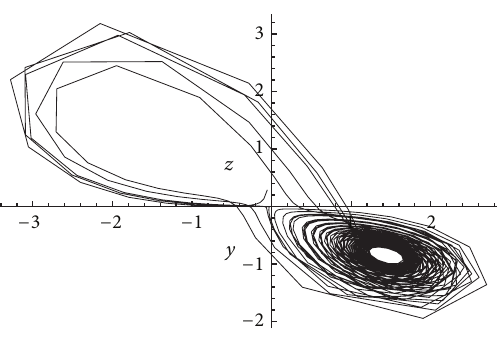
Figure 4: Phase portrait y - z 𝛼 = 0.96